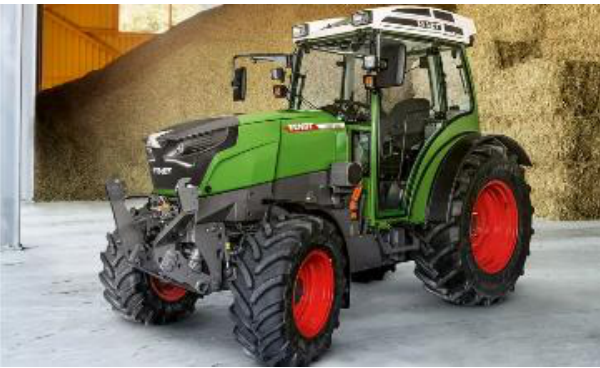
Fig. 25. Fendt e100 Vario [38]